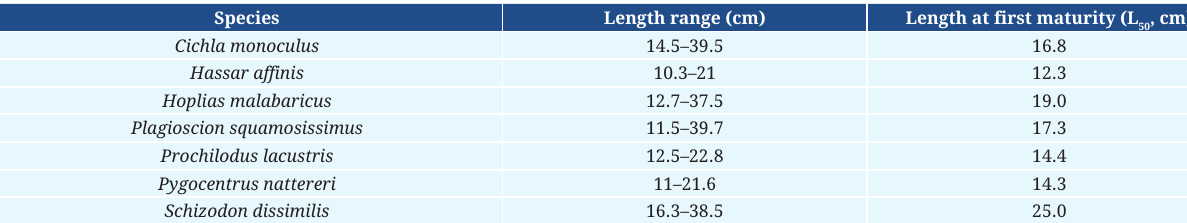
ni.bio.br | scielo.br/ni